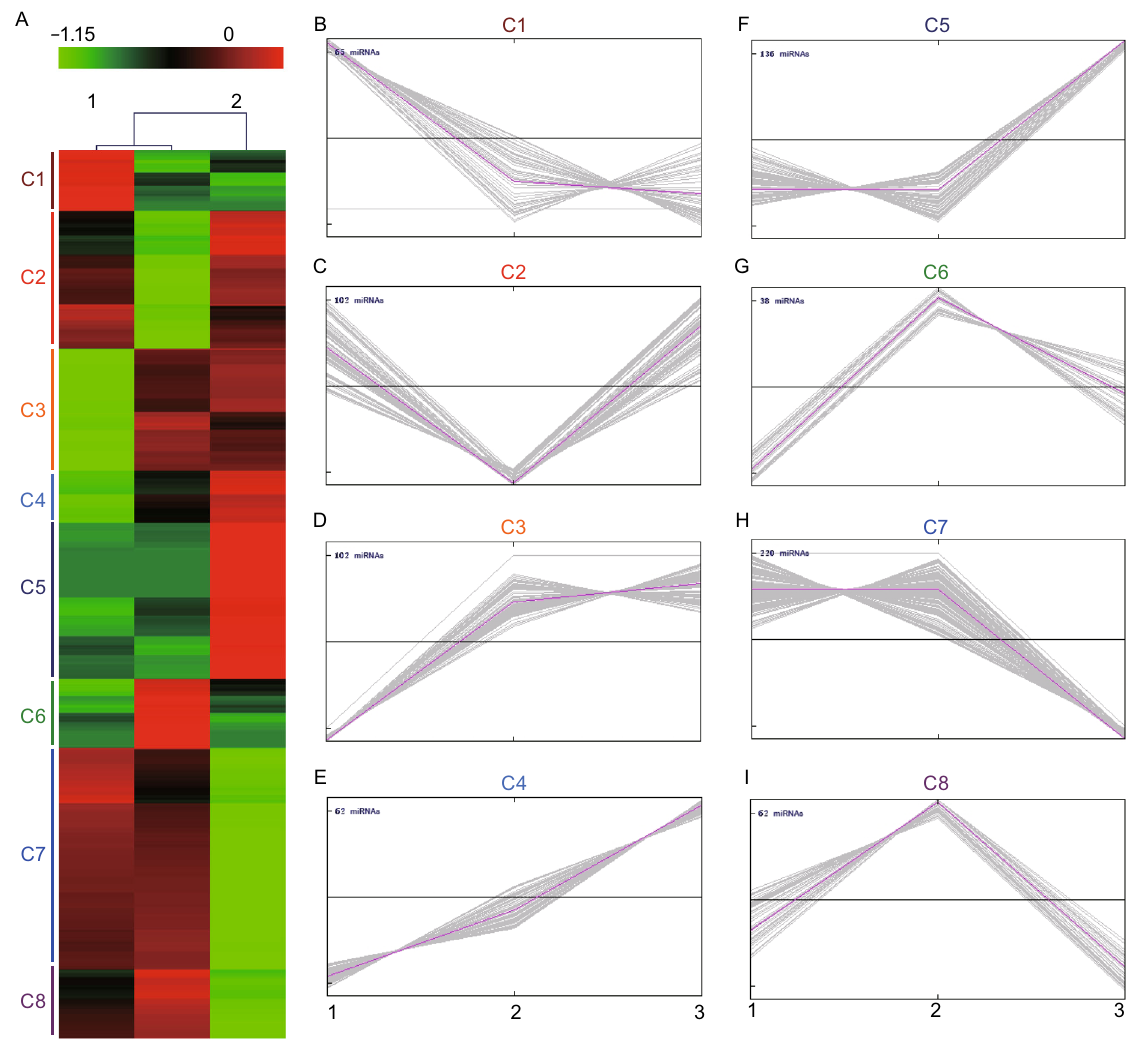
Figure 1. The expression pro fi le of miRNAs in different organs of amphioxus . (A) Heatmap illustrates the expression levels of miRNAs in the intestine (1), the gill (2) and the hepatic caecum (3). The expression levels were represented by a color scale with green as the lowest expression and red as the highest expression. Based on the expression pro fi le of miRNAs, the hierarchy cluster analysis was applied and eight different expression trends were labeled as C1 to C8. (B – I) The eight expression trends (C1 to C8) as indicated in (A) were plotted with the expression values of individual miRNAs. The horizontal line in the middle indicates the middle expression level. The miRNAs above the line are considered as high expression levels and the miRNAs below the line are considered as low expression levels. The expression levels of miRNAs are: 1) high in the intestine but low in the gill and hepatic caecum (B); 2) high in both the intestine and hepatic caecum (C); 3) low in the intestine but high in both the gill and hepatic caecum (D); 4) low in the intestine, medium in the gill and high in the hepatic caecum (E); 5) low in both the intestine and gill but high in the hepatic caecum (F); 6) low in the intestine, high in the gill and medium in the hepatic caecum (G); 7) high in both the intestine and gill, and low in the hepatic caecum (H); 8) medium in the intestine, high in the gill and low in the hepatic caecum